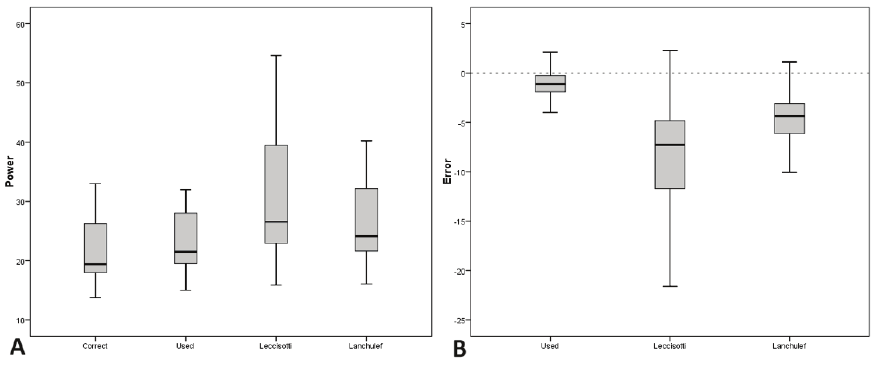
Figure 1. Box and whisker plot demonstrating calculated IOL powers (A) and the error using different formulas (B). Error is based on the difference between True power (Correct bar in A) and calculated powers using different formulas.